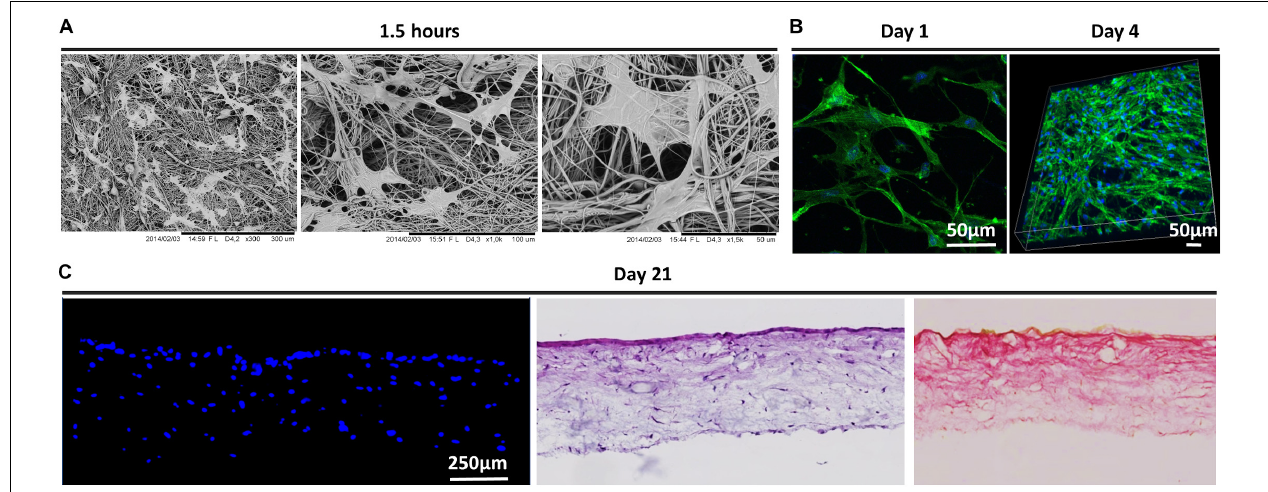
FIGURE 1 | (A) Morphology of human bone marrow MSCs attached to scaffolds 1.5 h after cell seeding as observed by SEM. Black scale bars represent 300 and 100 µ m on the left and right, respectively. (B) Confocal microscopy of MSCs on scaffolds 24 h and 4 days after seeding cells. Actin cytoskeleton arrangement is shown in green by fluorescent staining with rhodamine phalloidin and nuclei are depicted in blue by DAPI staining. White scale bars represent 50 µ m. (C) MSCs infiltration into scaffolds after 21 days post-culture as shown by fluorescent DAPI staining of cell nuclei in scaffold cryo-sections and H&E staining. Collagen matrix formation is observed in pink by pico-sirus red staining. Scale bars represents 250 µ